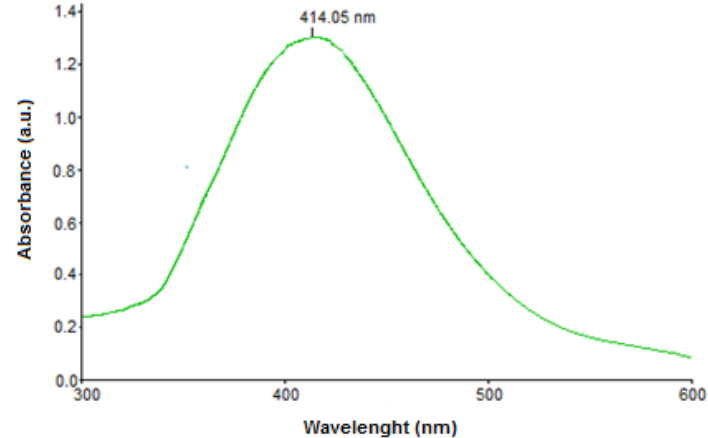
Figure 1. UV-Vis spectrum of AgNPs.